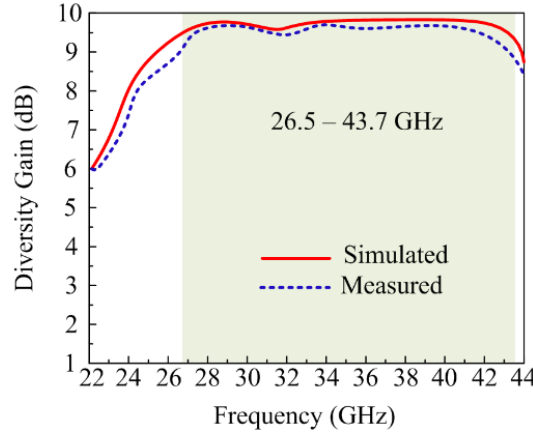
Figure 15. Comparison among predicted and measured DG.